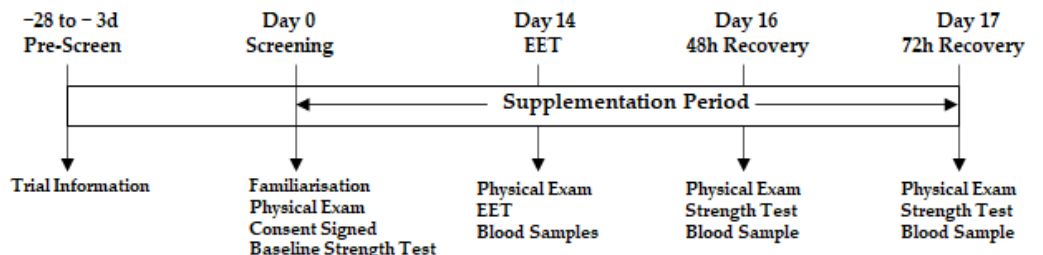
Figure 1. General schematic of trial design.